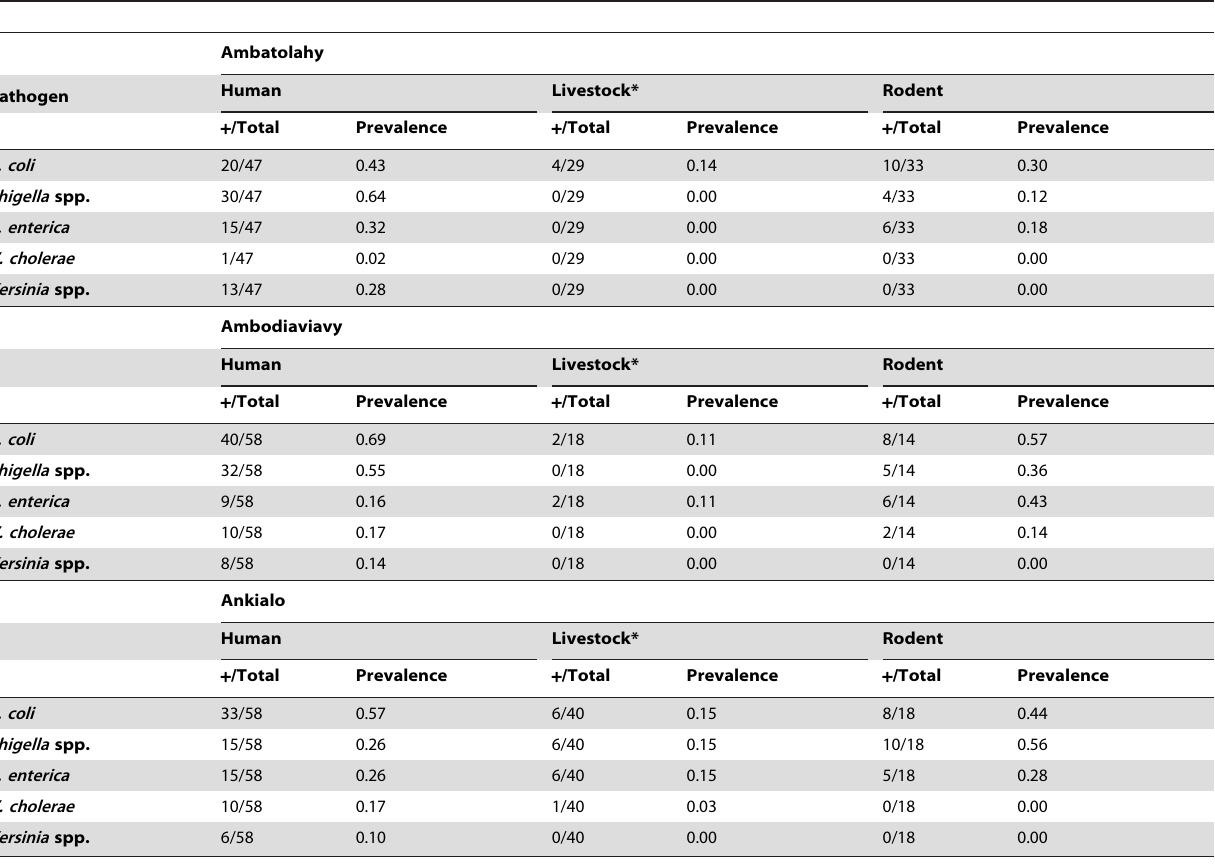
Table 3. Incidence of each Enterobacteriaceae species in humans, livestock, and rodents by